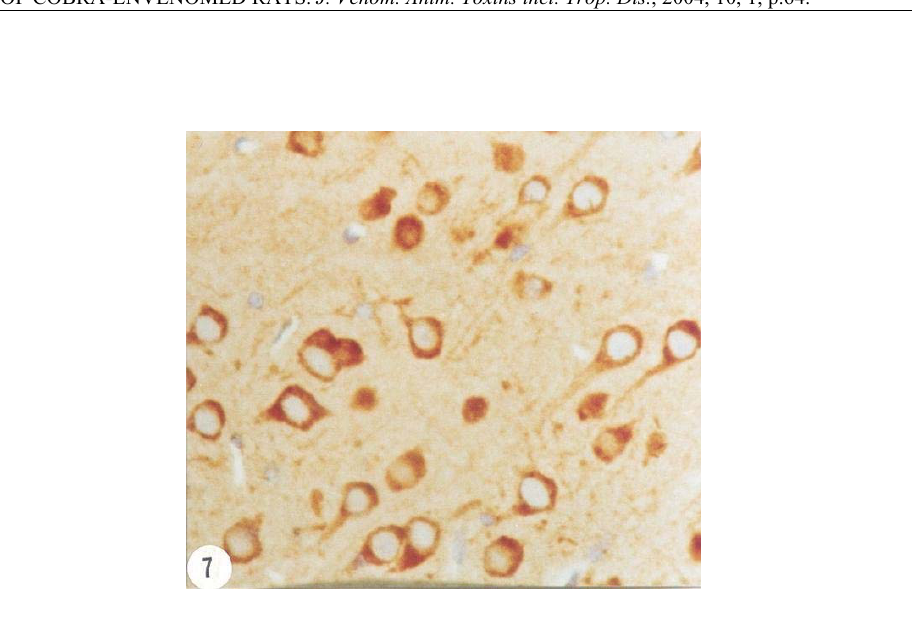
Figure 7. Intense NSE-positive reactivity in neurons 48 hr after high dose envenoming (X400)